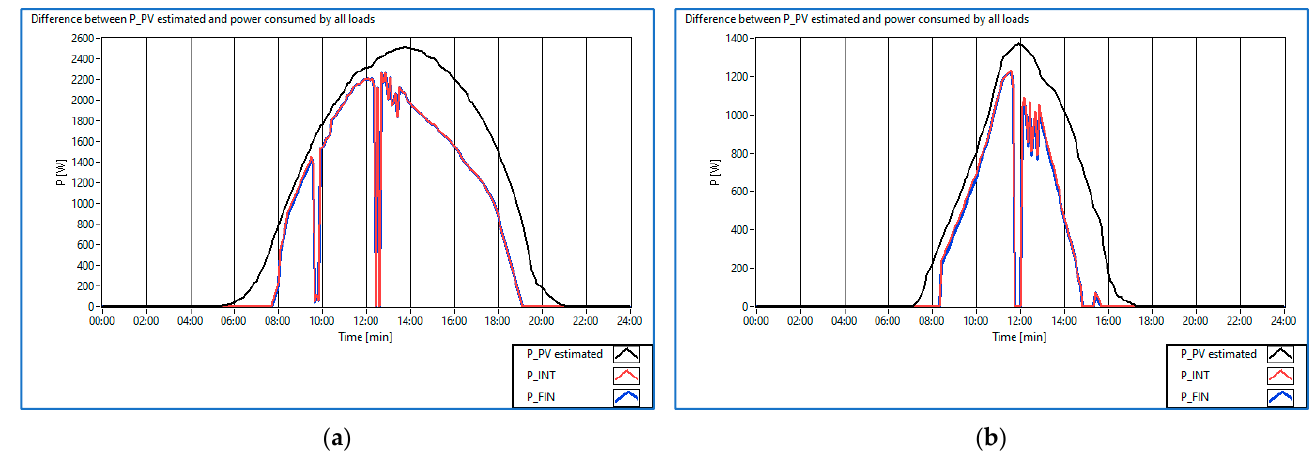
Figure 10. P PV estimated by RBF, P INT , and P FIN for ( a ) scenario 1; ( b ) scenario 2.